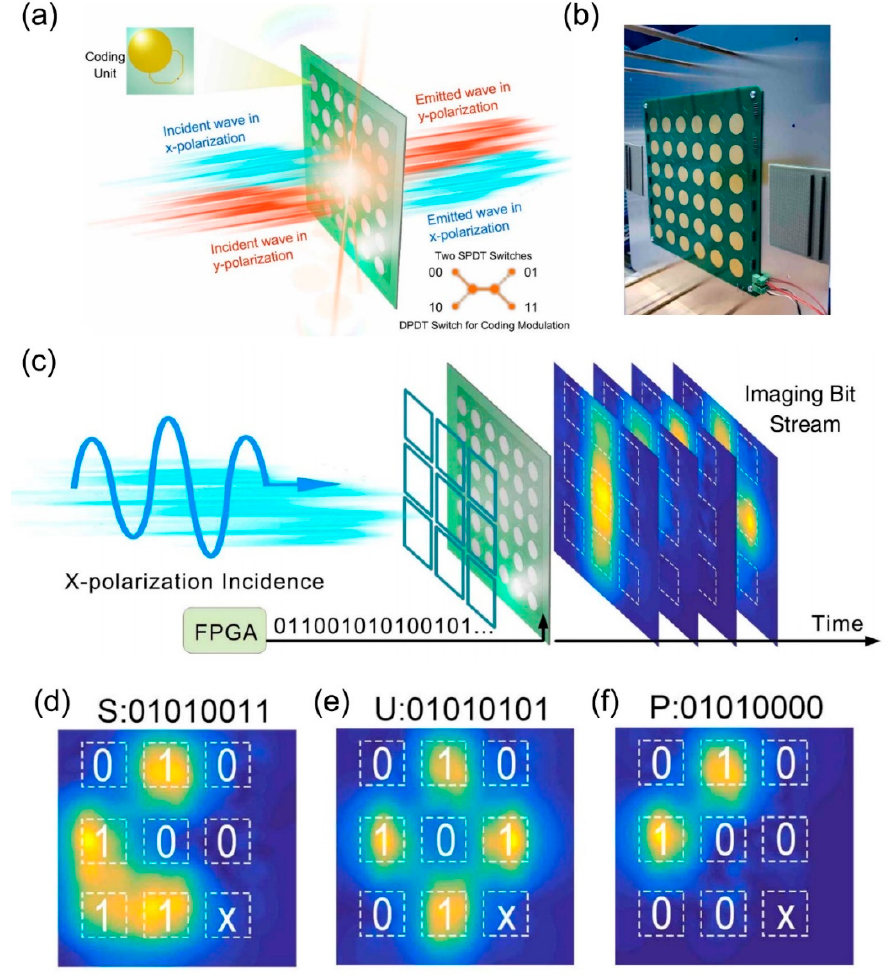
Figure 10. ( a ) Schematic of programmable metasurface based on SPDT switches (from Figure 1 of Ref. [98]). ( b ) The fabricated sample of the metasurface (from Figure 7a of Ref. [98]). ( c ) Schematic of the binary information representation and transmission (from Figure 6a of Ref. [98]) ( d – f ) The simulated near-field electric field distributions of three letters (SUP) with binary ASCII codes (from Figure 6f–i of Ref. [98]). Reproduced with permission from Ref. [98] under a Creative Commons